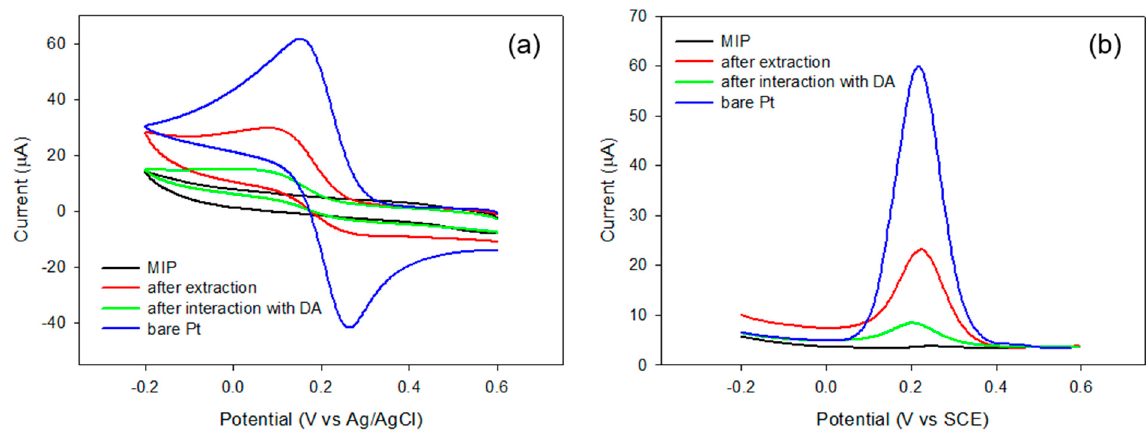
Figure 5. ( a ) Cyclic voltammograms of 5 mM of ferricyanide on a bare Pt electrode (blue profile), on an MIP-modified Pt electrode, before (black profile), and after (red profile) removal of the imprinted DA molecules, and on an MIP-modified Pt electrode after interaction with 0.1 mM of DA (green profile). Scan rate 50 mV/s. ( b ) DPV profile of 5mM of ferricyanide acquired in the same conditions of the cyclic voltammograms. Potential range from +0.6 V to − 0.2 V. Potential increment: 4 mV; sampling width: 20 ms; pulse amplitude: 50 mV; pulse period: 0.2 s; pulse width: 50 ms.